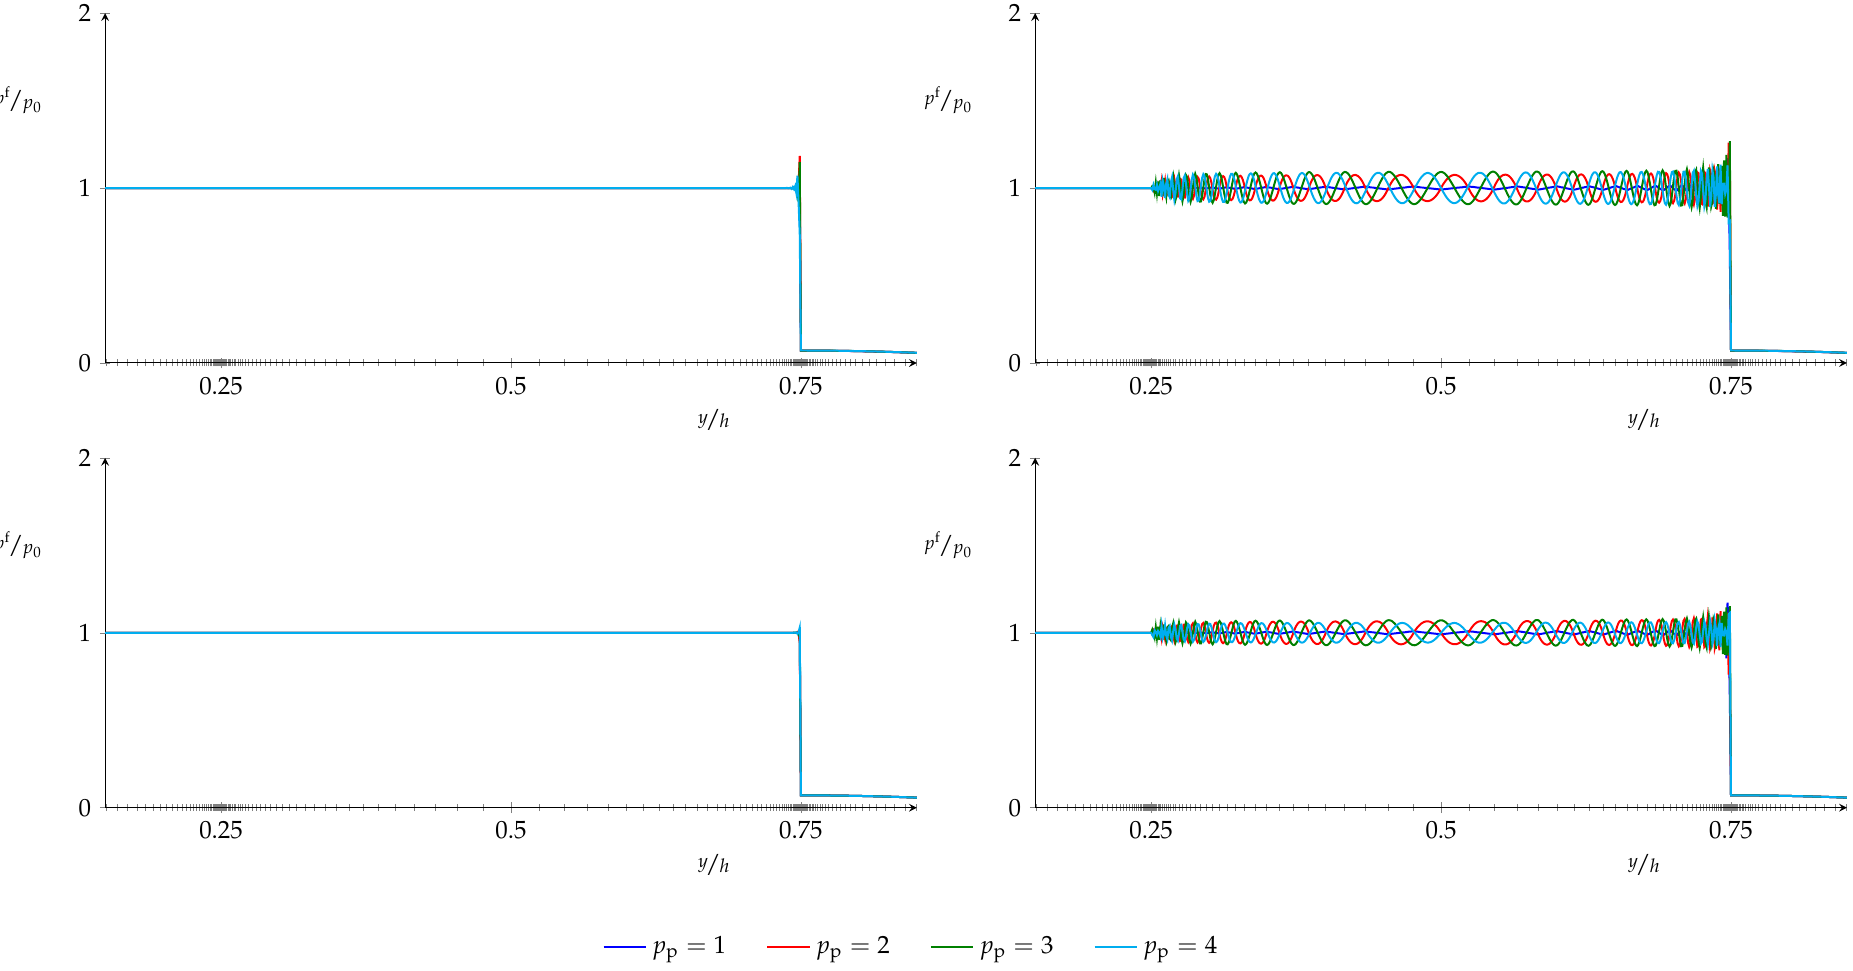
Figure 9. Numerical solution to the Haga problem using a graded mesh with small elements near the boundary layer and ∆ t = 1s. All figures are shown after two time steps. On the left the mixed order method, and on the right the equal order method. The continuity in the boundary layer is C p p − 1 in the top row, and C 0 in the bottom